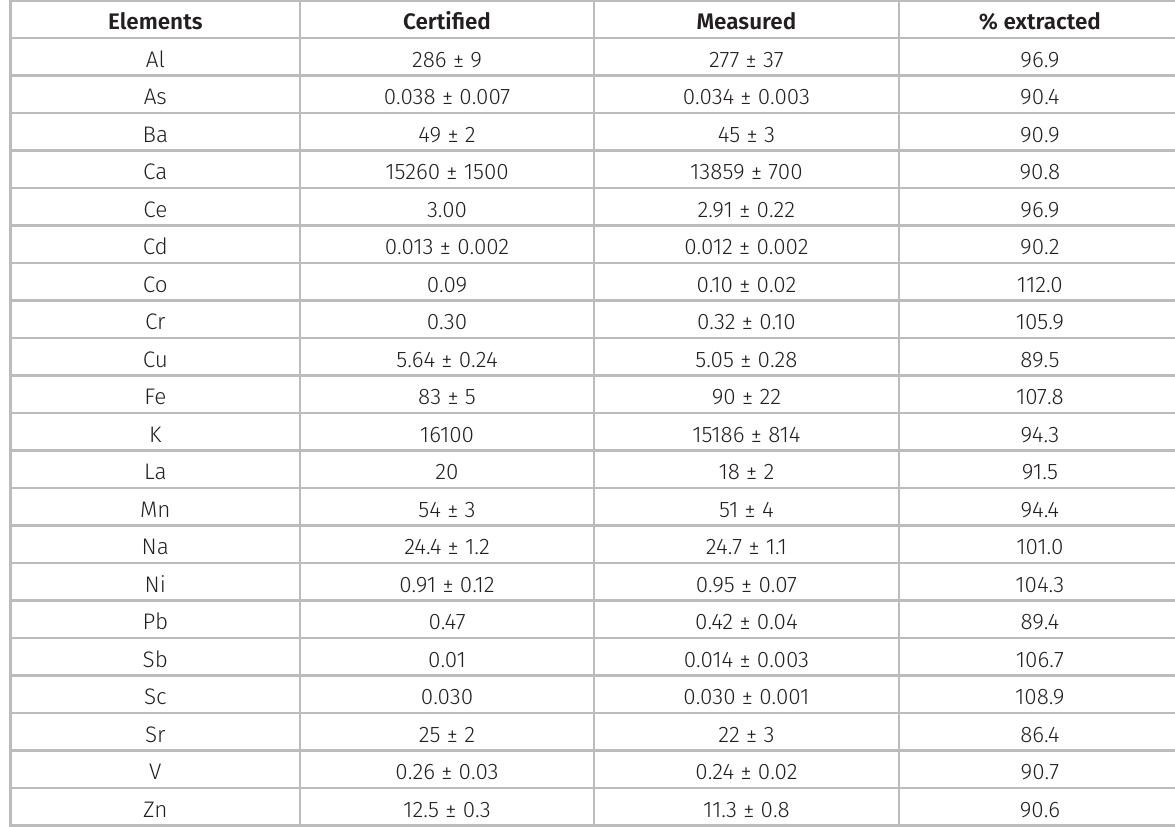
Table II. Values obtained for the Certified Reference Material NIST SRM 1515 (n=3).